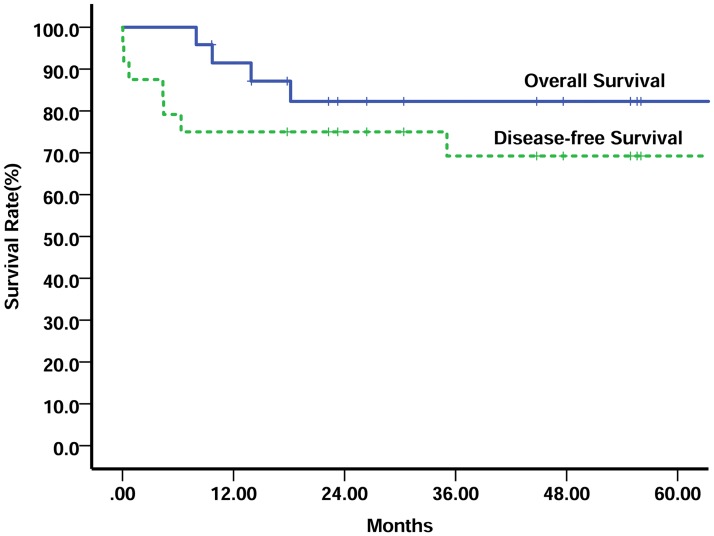
Overall survival and disease-free survival of the entire group.